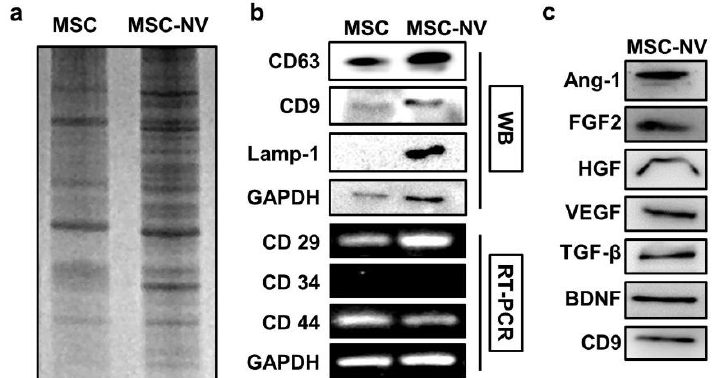
Figure 2. ( a ) Coomassie blue gel of lysates from MSCs and MSC-NVs, showing different patterns after the fabrication of MSC-NVs. ( b ) Western blot (WB) analysis of exosome markers (CD63, CD9, and Lamp-1), and reverse transcriptase–polymerase chain reaction (RT-PCR) analysis of MSC markers (CD29+, CD34 − , and CD44+) in MSCs and MSC-NVs. ( c ) Evaluation of various growth factors and neurotrophic factors contained inside MSC-NVs.